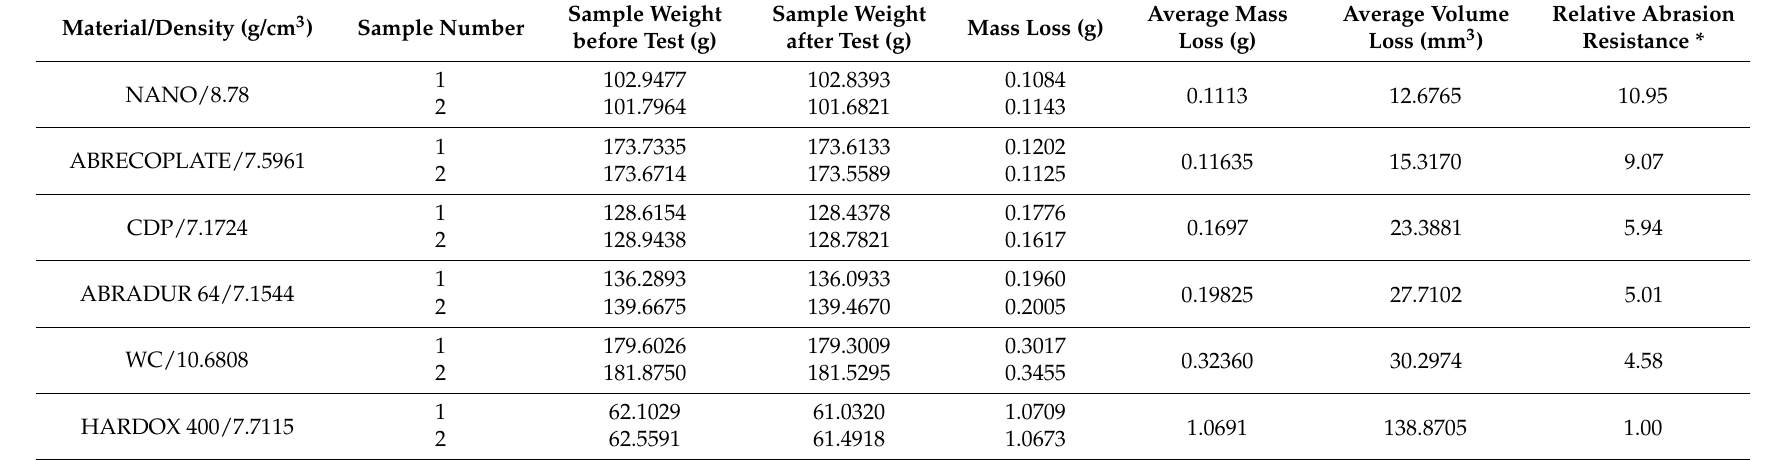
Table 7. ASTM G65-00 abrasion resistance test